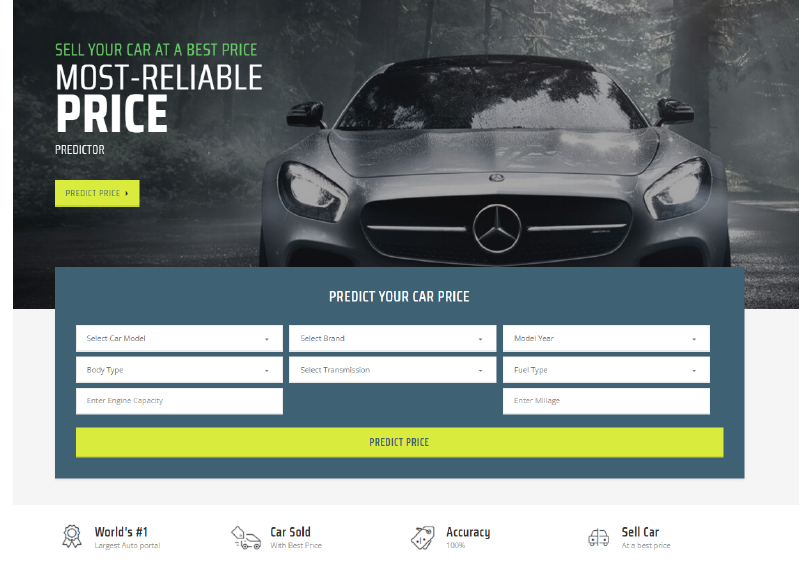
Figure 23. Screenshot of the webpage.